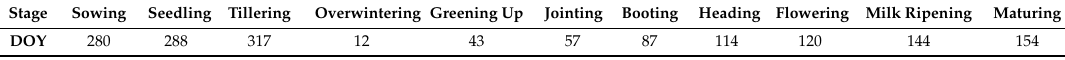
Figure 2. Time series of daily precipitation (blue) and average temperature (red) in the test region during the growth stage of winter wheat from DOY 283 to DOY 169 (1 October 2016 to 6 June 2017). Table 3. The beginning dates of winter wheat phenological stages as recorded at Anyang station.